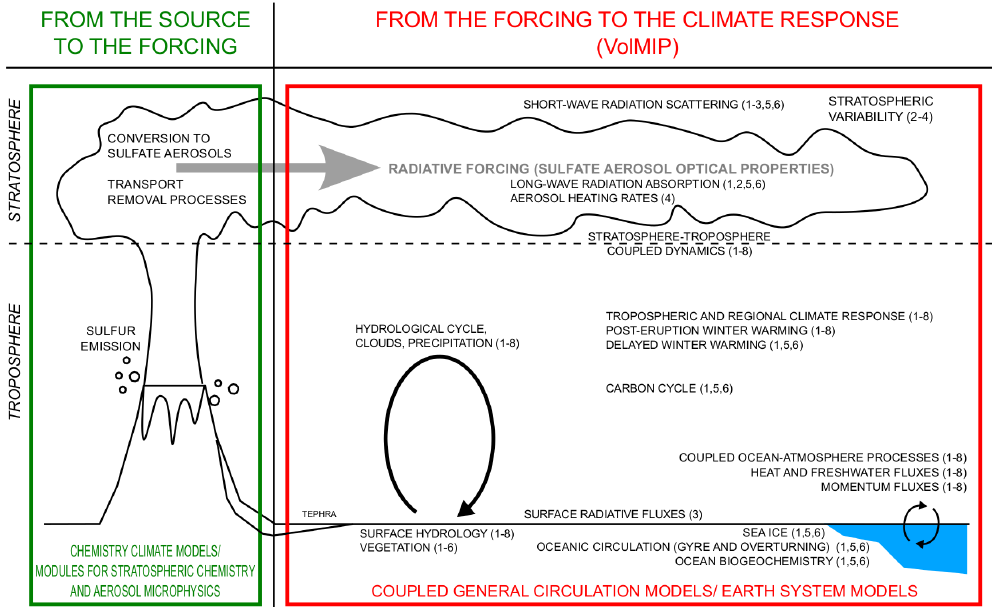
Figure 2. Illustrating the dominant processes linking volcanic eruptions and climatic response, with an overview of VolMIP experiments: 1 is volc-long-eq; 2 is volc-pinatubo-full; 3 is volc-pinatubo-surf; 4 is volc-pinatubo-strat; 5 is volc-long-hlN/-hlS; 6 is volc-cluster-ctrl/- mill/-21C; 7 is volc-pinatubo-slab; 8 is volc-pinatubo-ini. The red box encompasses the processes related to the climatic response to volcanic forcing that are accounted for in VolMIP; the green box encompasses the processes regarding volcanic forcing that are neglected by VolMIP.